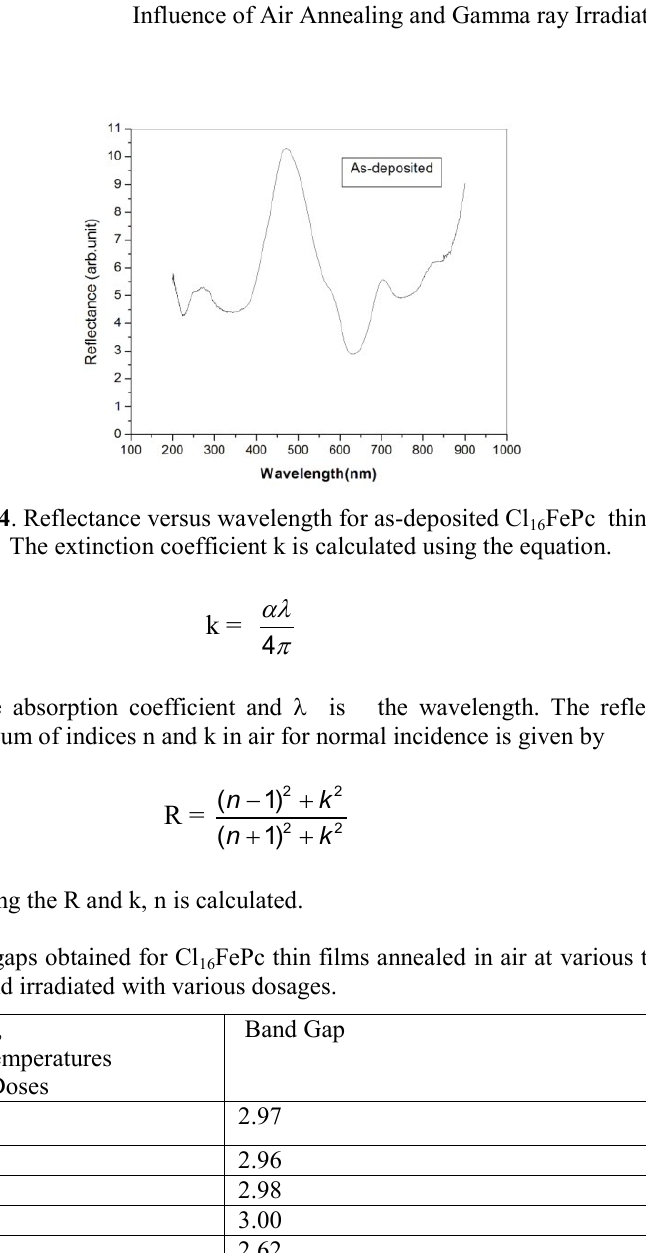
Figure 4 . Reflectance versus wavelength for as-deposited Cl